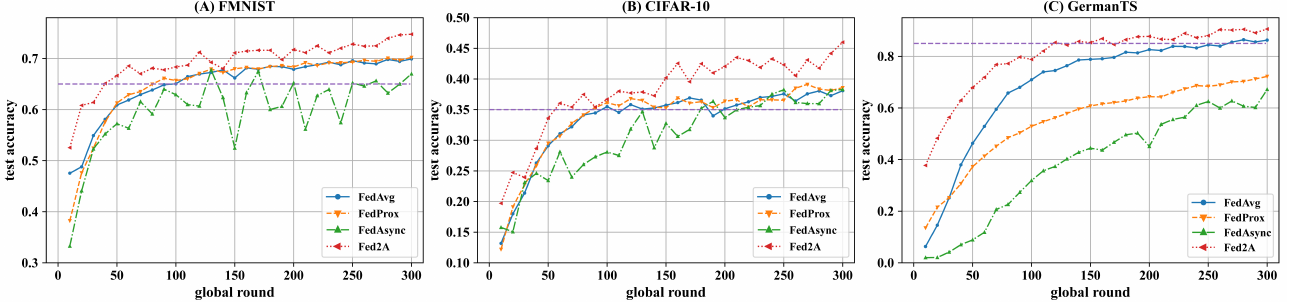
Figure 6. The accuracy curve of Fed2A compared with the baselines in ( A ) FMNIST; ( B ) CIFAR-10; and ( C )